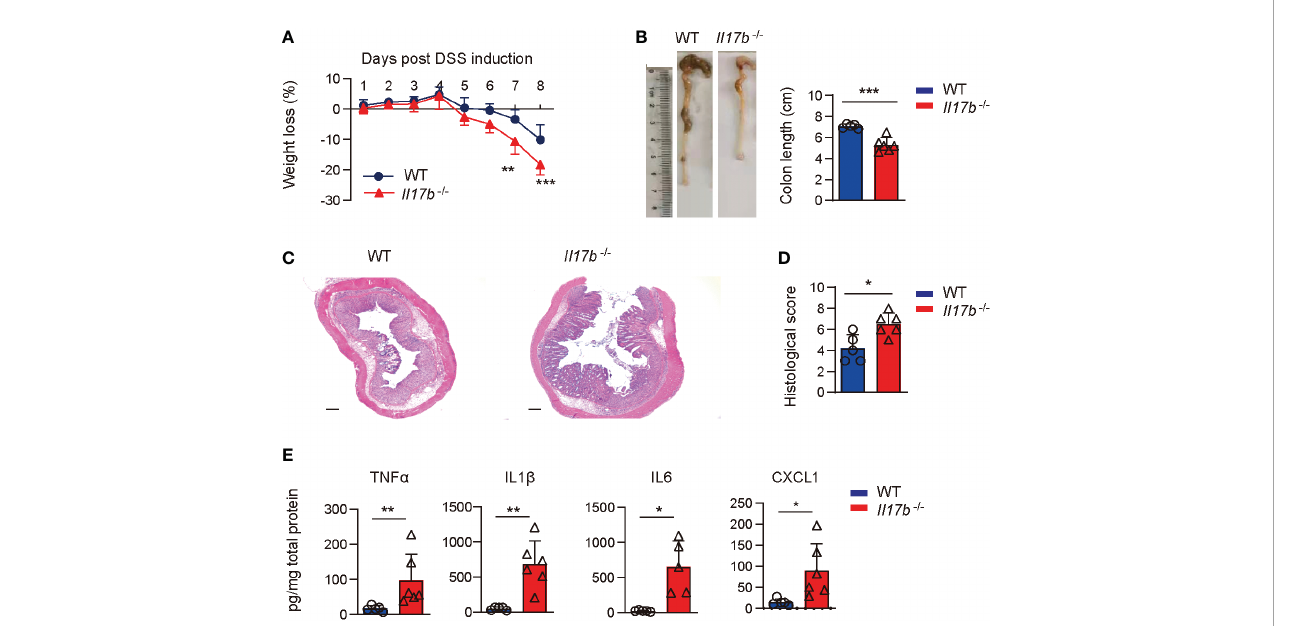
FIGURE 2 IL17B de fi ciency results in exacerbated DSS-induced colitis. WT and Il17b -/- mice were fed with 2.5% DSS water for 6 days. n = 5 - 6 mice/group. (A) Body weights were measured daily and body weight loss relative to initial weight were calculated. Data are presented as mean ± SD. ** P < 0.01, *** P < 0.001, evaluated by 2way ANOVA analysis with Sidak`s multiple comparisons test. (B) Colons were removed at day 8 and the colon length was measured. (C) Representative H&E staining of colon tissues. Scale bar: 200 m m. (D) Quanti fi cation of histological score from colonic sections in (C, E) The supernatants of colon tissue homogenates were assayed for cytokine by ELISA. For (B, C) , data are mean ± SD and are representative of at least 3 independent experiments. * P < 0.05, ** P < 0.01, *** P < 0.001, evaluated by unpaired t